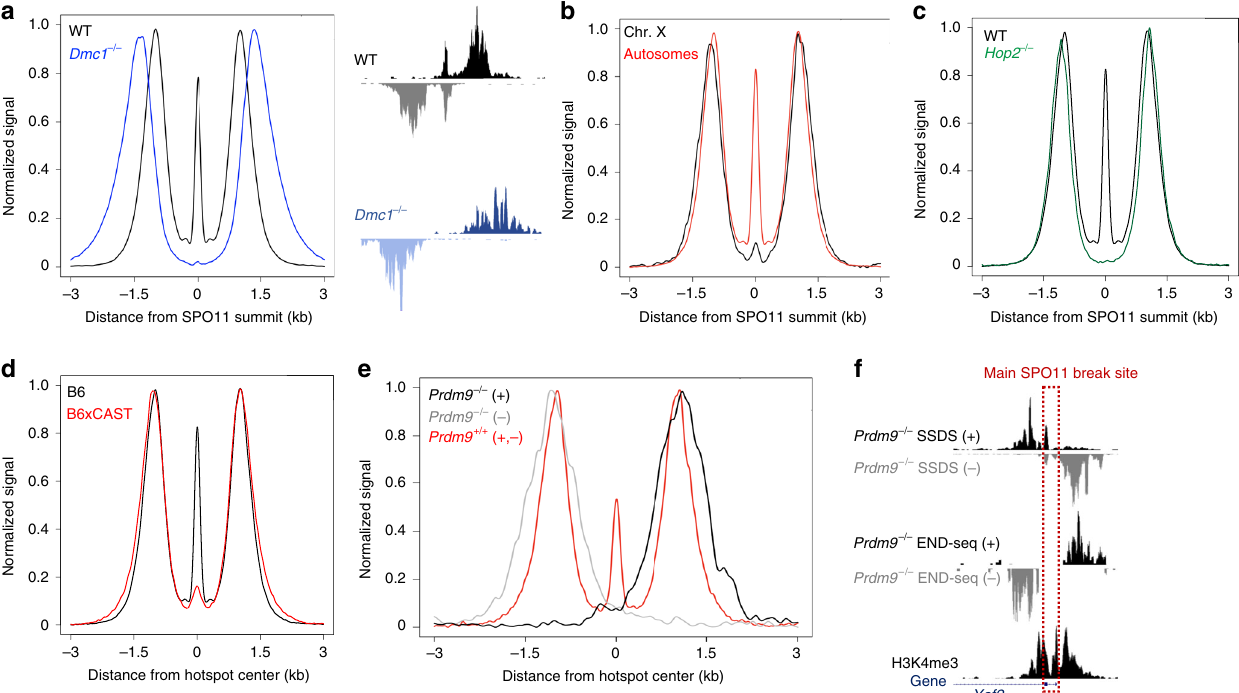
Fig. 7 WT central peak relies on homolog engagement and PRDM9. a Aggregated END-seq signal around SPO11 oligos, with hotspot example, showing absence of SPO11 central peak in Dmc1 – / – . b Reduction in central signal at non-PAR X chromosome hotspots; aggregated signal on ChrX compared with all autosomes. c Aggregated END-seq signal around SPO11 oligos showing absence of SPO11 central peak in Hop2 – / – . d Aggregated END-seq signal of B6 (centered on B6 SPO11 oligos) versus B6xCAST hybrid (centered on hybrid SSDS hotspot centers). e Prdm9 – / – END-seq signal aggregated around default SSDS hotspot centers at ~ 200 sites with least overlap in SSDS top and bottom strands. WT END-seq is centered around WT SPO11 oligos at PRDM9- dependent hotspots. f Prdm9 – / – SSDS and END-seq tracks at a single default hotspot ( Yaf2 gene) with minimal SSDS top and bottom strand overlap. Main SPO11 break site (red dotted line) is inferred from SSDS pattern. Aggregate plots in all panels are normalized to the same height for visual completely released, adapters ligated to the right end of the break would contribute to central peak signal. The fully processed end will align to the top ( + ) DNA strand, whereas adapters ligated to (Fig. 8b, top, left end of the DSB) would result in the release of the the left end will align to the bottom ( – ) strand (Fig. 2c, Fig. 8a, SPO11-oligo that would generate a protein-free 3 ′ overhang. This left). When reads from all hotspots are aggregated, the distal (SPO11-free) DNA end would in turn be blunted by END-seq resection signal around SPO11 cuts exhibited this “ correct ” and sequencing reads would be detected within the distal, long- polarity for the top and bottom strands (Fig. 8a, left). However, a range resection peaks (Fig. 8b, bottom, left end of the DSB). In close examination of the WT END-seq reads associated with the contrast, the other side of the DSB would be incompletely central signal unexpectedly revealed a “ wrong ” polarity, in which resected by MRE11 and retain SPO11 covalently bound to a two- top strand reads aligned slightly to the left within the NDR and nucleotide, 5 ′ overhang (Fig. 8b, top, right end of the DSB). END- bottom strand reads aligned slightly to the right (Fig. 8a, right). seq detection (with ExoVII + ExoT) would then remove SPO11 and sequence the remaining dsDNA, with the fi rst nucleotide sequenced being the SPO11 break site itself (Fig. 8b, bottom, right end of the DSB). This would result in top and bottom strand central peak reads with reversed polarity within the NDR, as and bottom strand shift of ~ 60 nts in the “ wrong ” orientation SPO11 breaks to the left of the NDR center would contribute top (Fig. 8a, right). Detecting a signi fi cant reversal in the expected strand reads aligning left of center, and SPO11 breaks to the right polarity indicated that the central peak was not simply SPO11cc, would contribute bottom strand reads aligning right of center (Fig. 8b). In a population of spermatoctyes in which both events occur among the cells, END-seq would detect an overall aggregated signal of resection reads with correct polarity and central reads with reversed polarity (Fig. 8b, bottom).